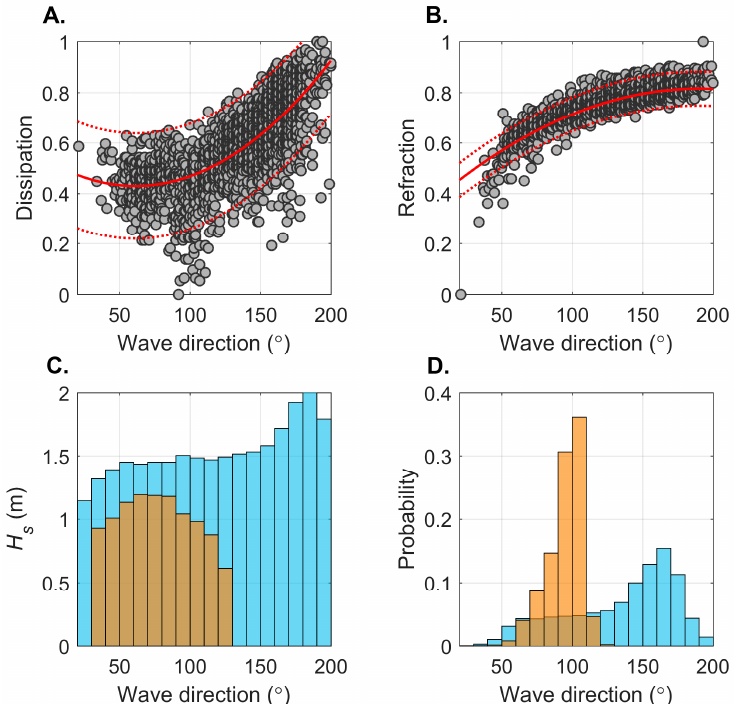
Figure 8. Rates of energy dissipation ( A ) and refraction ( B ) for waves approaching Narrabeen between August and November 2011. Wave direction on the x ‐ axis relates to the offshore (mid ‐ shelf) wave direction as measured at the Sydney buoy. Polynomial functions (solid red lines) describe the dissipation/refraction curves with 95% confidence intervals (dashed red lines). The long ‐ term wave height distribution ( C ) and occurrence probability of wave directions ( D ) are shown for the Sydney offshore (blue, observed) and Narrabeen nearshore (orange, modelled) for the period 1992–2016. The Narrabeen nearshore data was obtained by applying the dissipation and refraction coefficients in ( A ) and ( B ) to the offshore data.